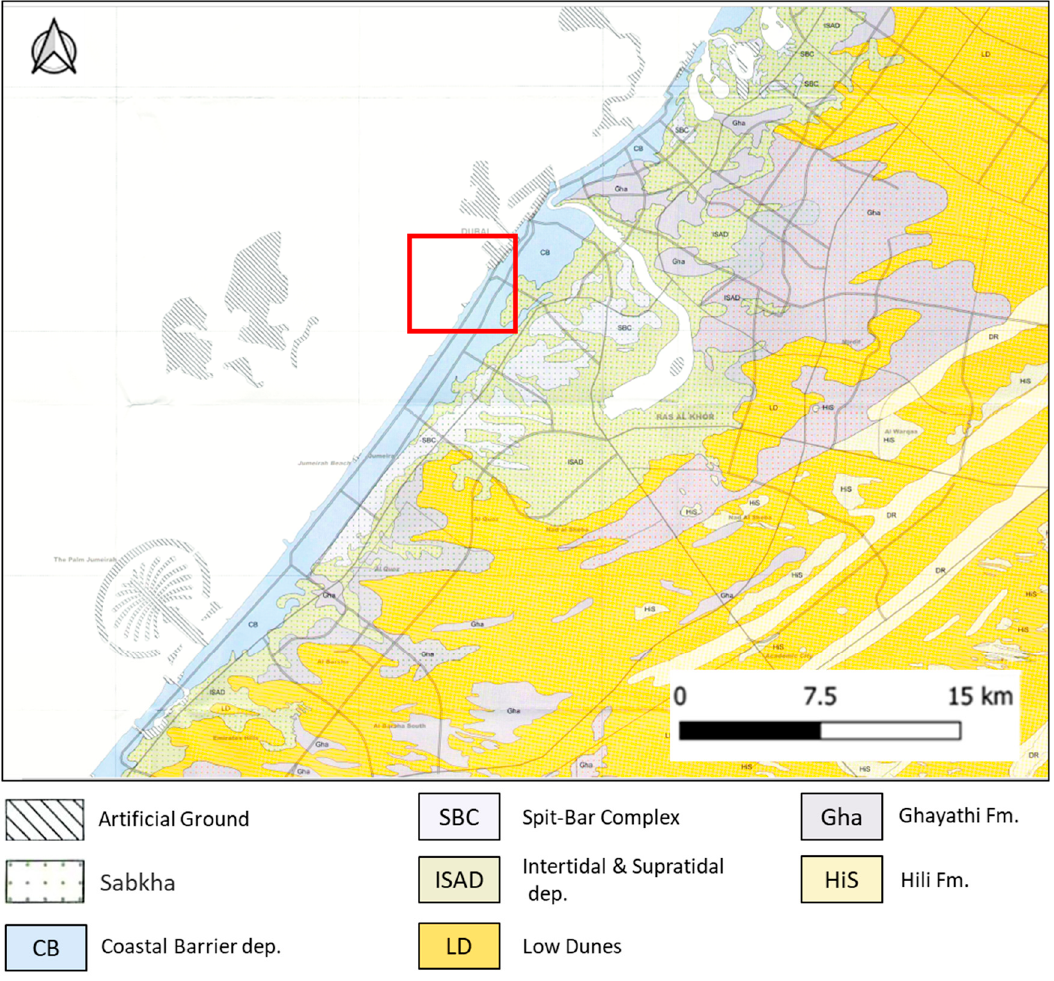
Figure 4. Extract of the geological map of the coastal area of Dubai (UAE) [37]. the study area is enclosed in the red box.